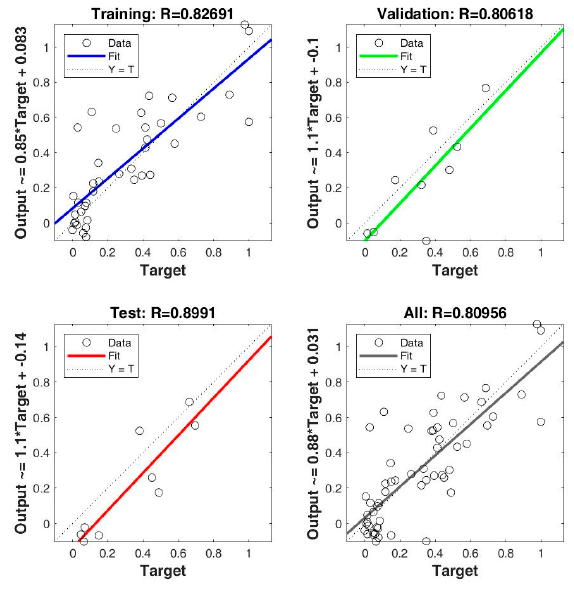
Figure 3. BP neural network regression analysis diagram.